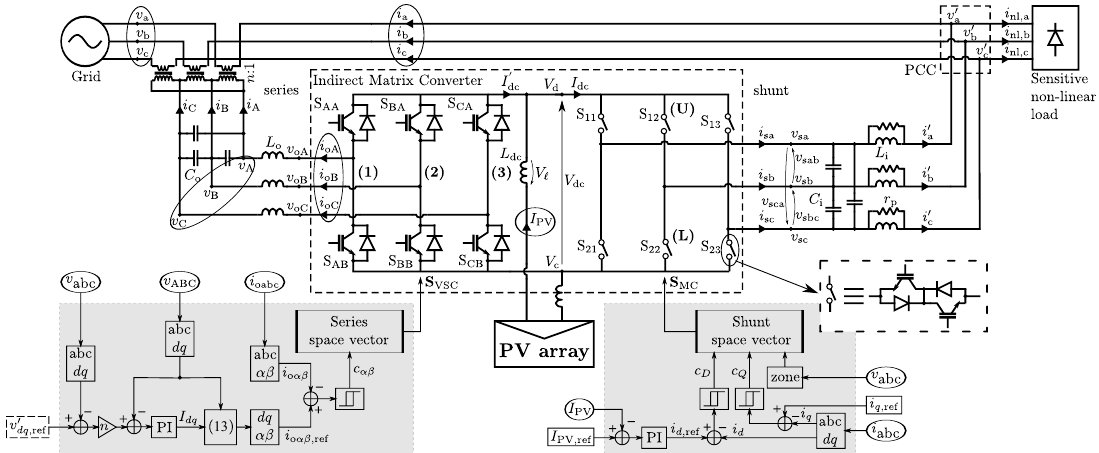
Figure 1. Proposed Indirect Matrix Converter (IMC)-based Photovoltaic Unified Power Quality Conditioner (PV-UPQC) with a Photovoltaic (PV) array injecting current into the ‘dc link’ and corresponding control circuit (encircled variables are